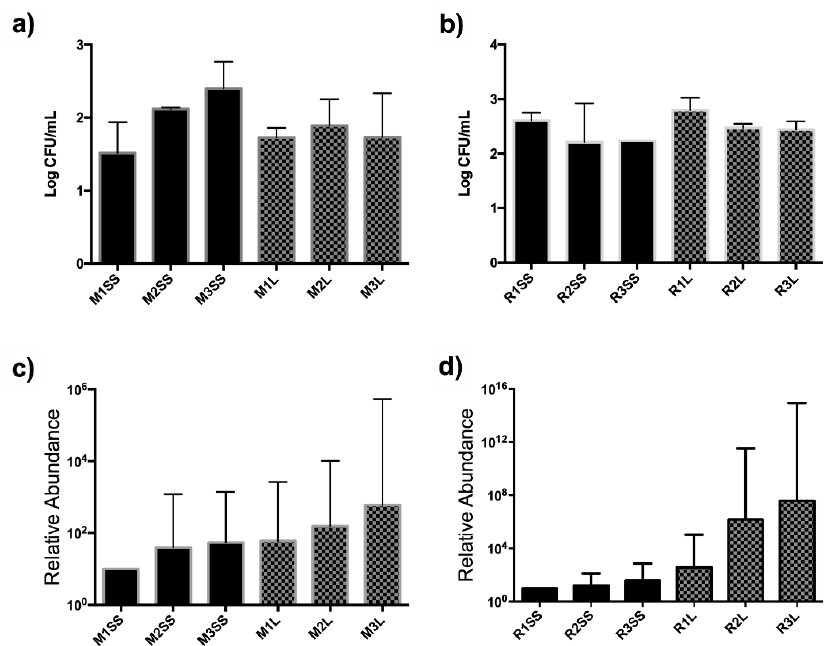
Figure 2. Colony-forming unit (CFU) quantification and relative abundance (qPCR) of bacterial communities in M. spicata and R. officinalis . CFU quantification in ( a ) M. spicata and ( b ) R. officinalis ; relative abundance (qPCR) of bacterial communities in ( c ) M. spicata and ( d ) R. officinalis (M1SS: mint